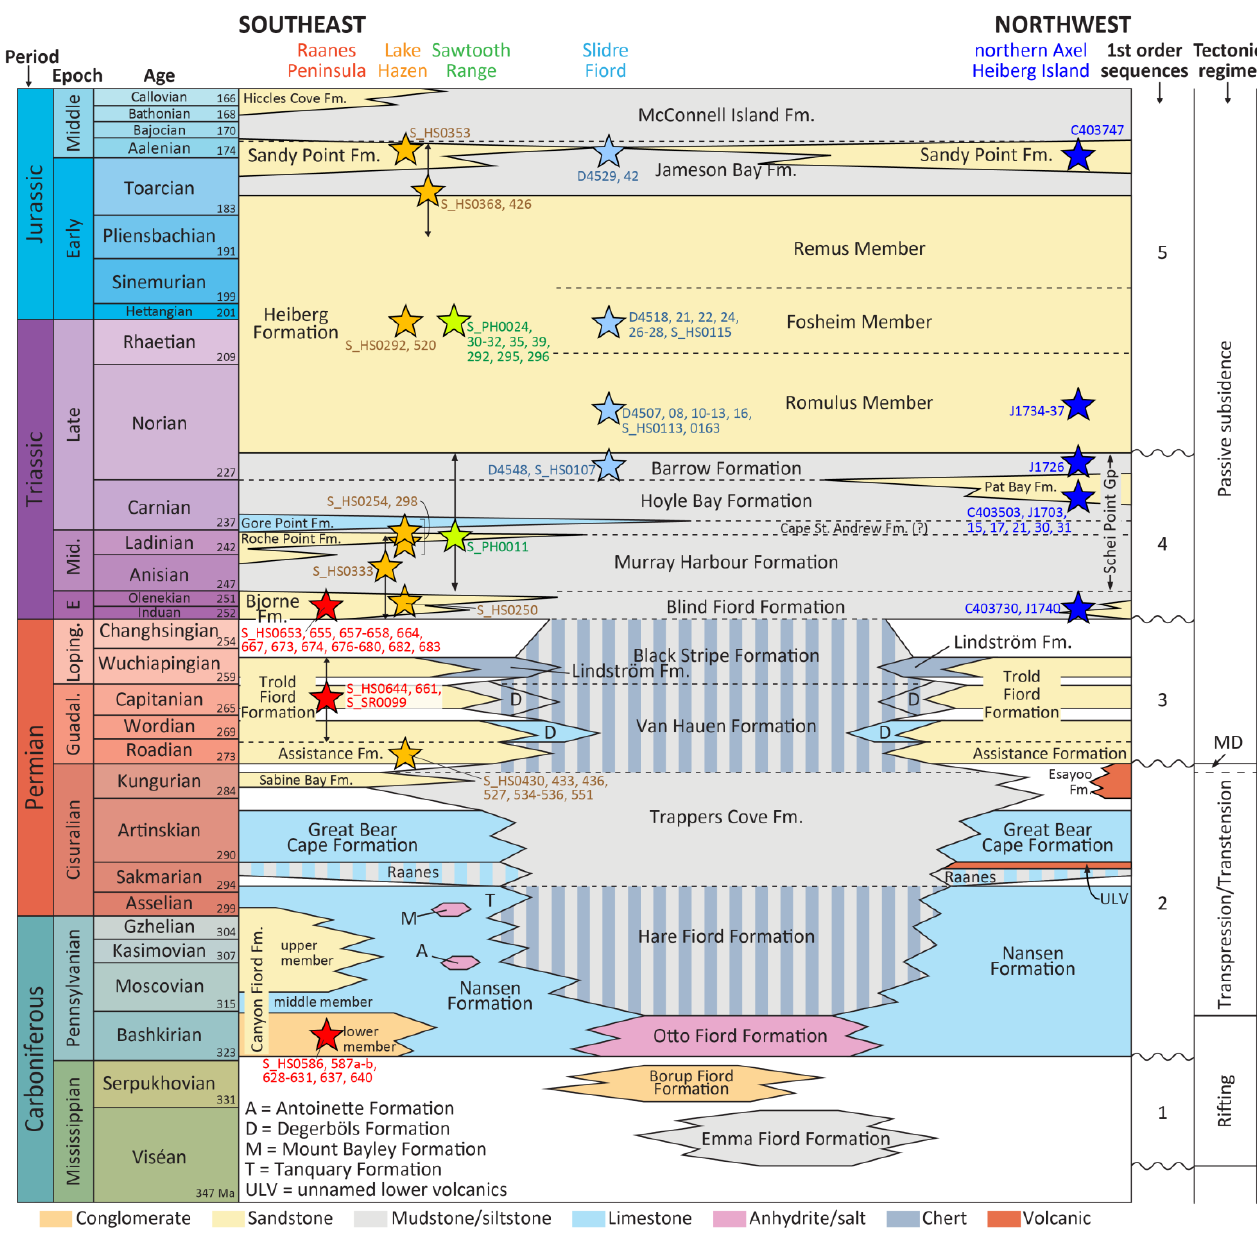
Figure 2. Carboniferous to Middle Jurassic lithostratigraphic framework of the eastern Sverdrup Basin showing the sampled units. The stars represent samples. The figure is adapted from Lopez- Mir et al. [68] using information in Davies and Nassichuk [63], Embry [17,20,23,69] and Embry and Beauchamp [18,19]. Numerical ages are from Cohen et al. [70]. First-order sequences and tectonic regime are from Embry and Beauchamp [18]. MD = Melvillian